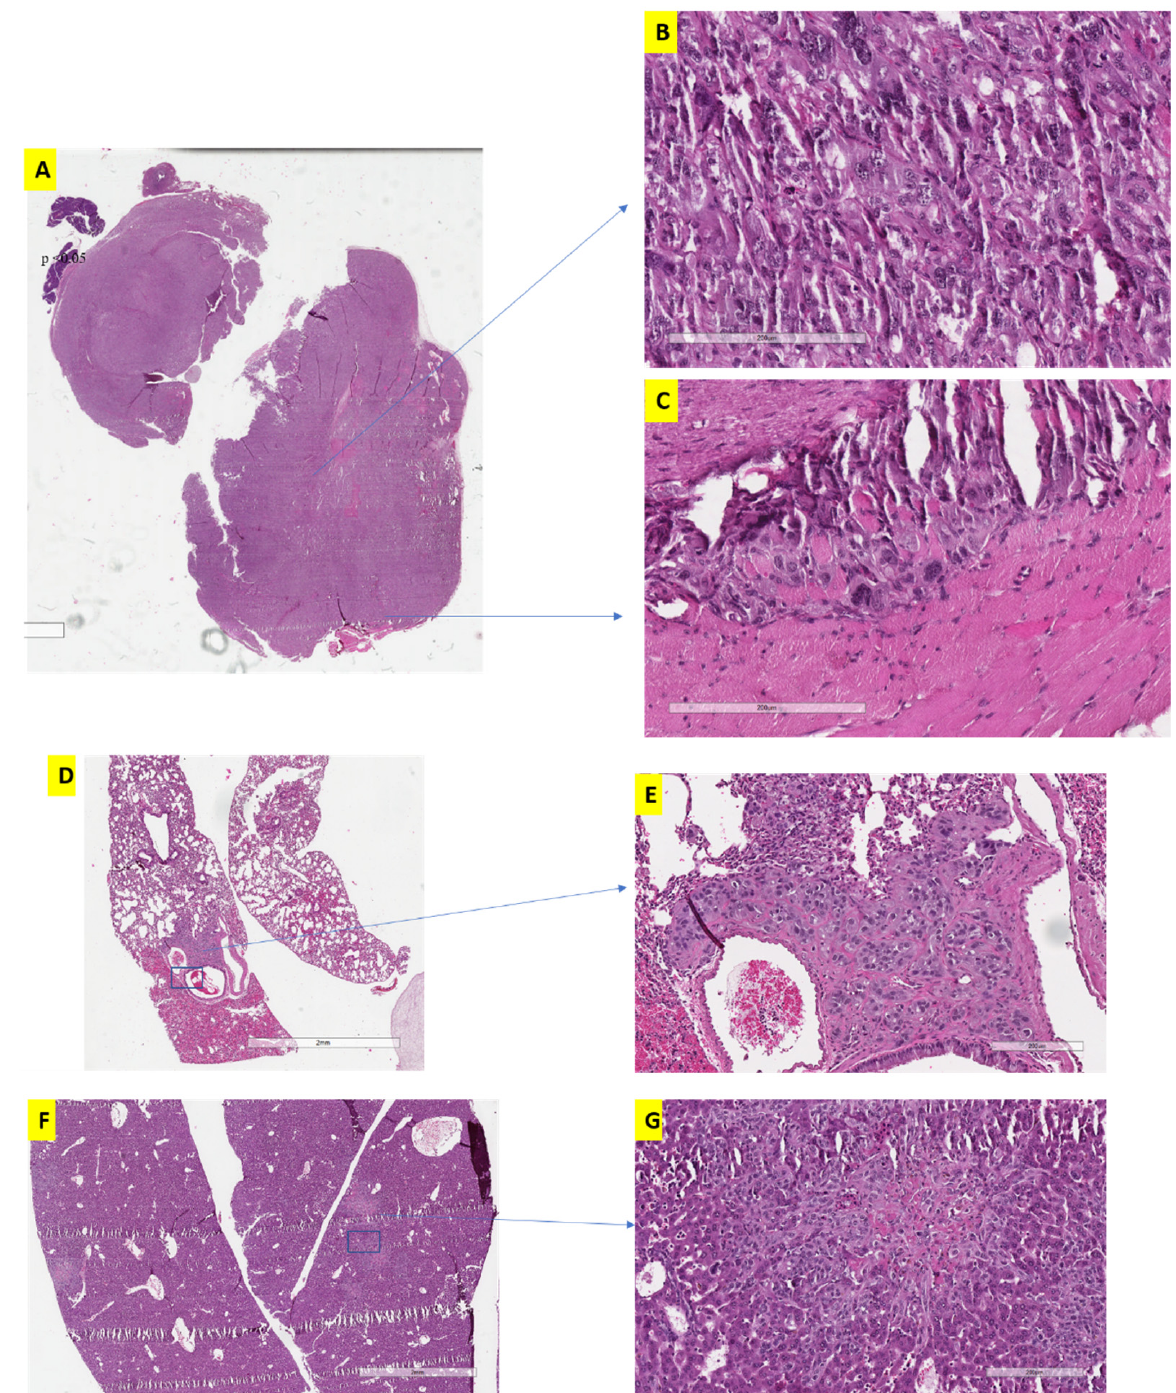
Figure 3. Histopathologic changes in the traditional scheduling regimen after three cycles of treatment (9 weeks). ( A ) lower power magnification showing infiltrative tumor border into surrounding tissues; ( B ) high power magnification showing giant cells with bizarre nuclei and multi-nucleation. ( C ) high power magnification showing infiltrative border with tumor cells invading into the surrounding tissues. ( D ) remote metastatic lesion in lung. ( E ) higher magnification of ( D ) showing metastatic deposits in lung. ( F , G ) metastatic deposits in the liver (low and high magnification, re- spectively).